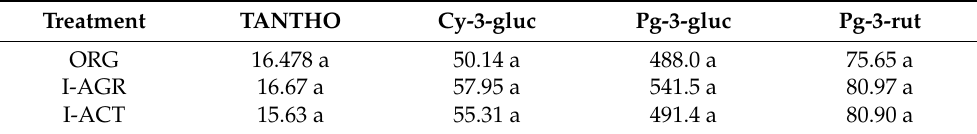
Table 5. Effects of cultivation management on the concentration of total anthocyanins (TANTHO)